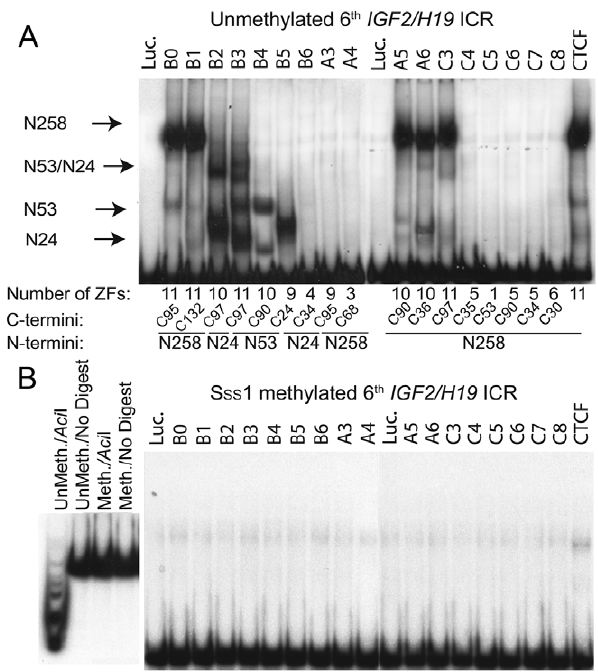
Figure 7. BORIS isoforms bind to the human IGF2/H19 ICR in a methylation-sensitive manner. ( A ) Binding of in vitro translated BORIS isoforms to the sixth CTCF target site in the human H19 ICR by EMSA. In vitro translated CTCF and luciferase proteins were used as positive and negative controls, respectively. The DNA-protein shifts corresponding to the particular N- termini are indicated by arrows. The number of ZFs and alternative N-and C-termini for each isoform are indicated at the bottom of gel. ( B ) DNA binding of BORIS isoforms to the H19 ICR is methylation-sensitive. EMSA of BORIS isoform binding performed with Sss I-methylated H19 ICR probe shows that none of 17 BORIS isoforms bound to the methylated H19 ICR. The left panel shows the quality control of the methylated probe by digestion with methylation-sensitive restriction endonuclease Aci I of 32 P-labeled methylated and unmethylated H19 ICR